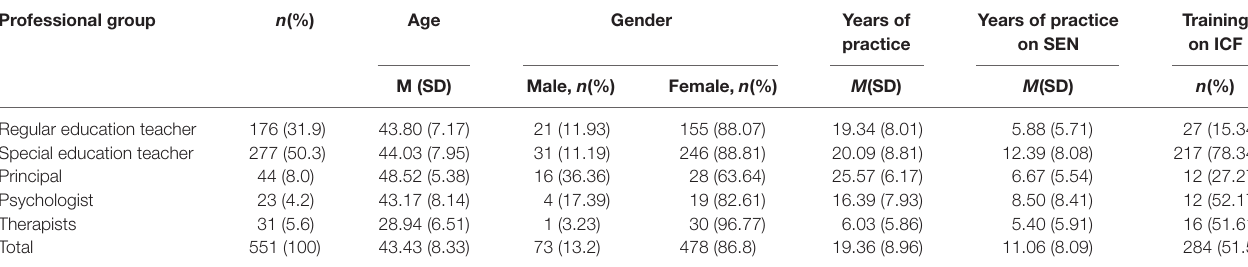
Table 2 | Demographic characteristics of respondents. Professional group